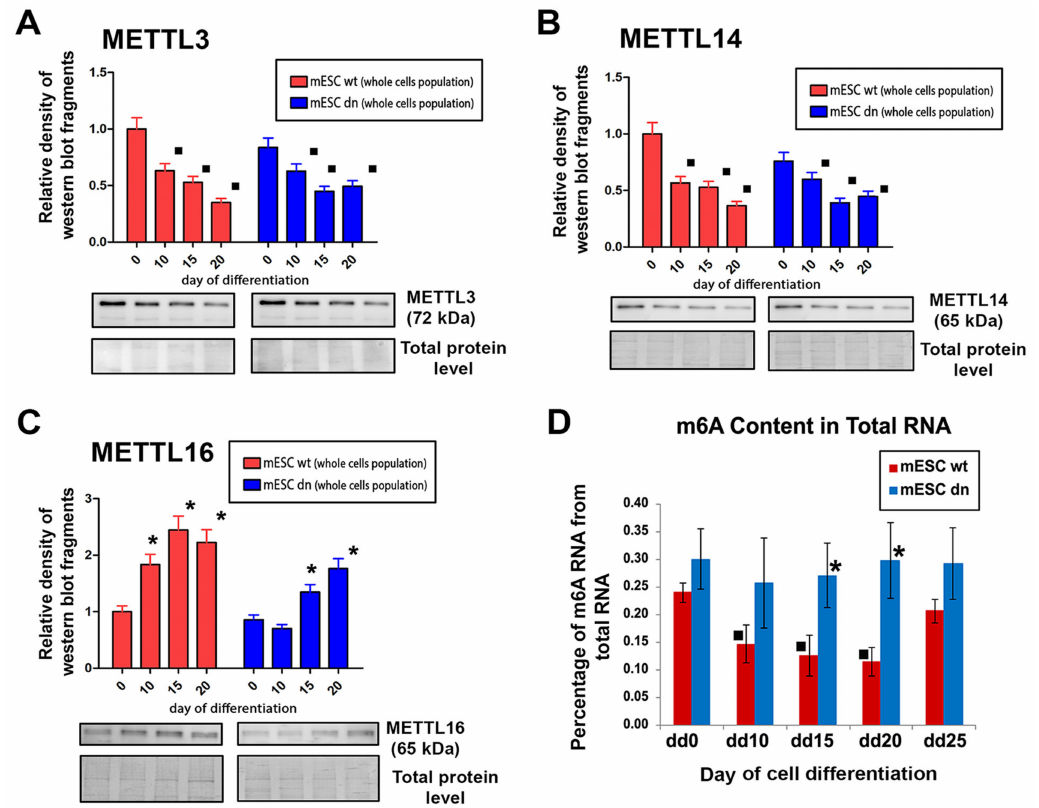
Figure 4. The levels of METTL3 / METTL14, and METTL16 or m6A in RNAs analyzed in HDAC1 wild type (wt) and HDAC1 depleted (dn) mESCs di ff erentiated into multicellular cell populations, including cardiomyocytes. Data from Western blots are shown in the following panels ( A ) METTL3, ( B ) METTL14, and ( C ) METTL16 in HDAC1 wt mESCs and HDAC1 dn mESCs. Squares ( (cid:4) ) show statistically significant di ff erences at p ≤ 0.05 (a decrease in protein levels during di ff erentiation). Data are significantly di ff erent from control values at dd0. Asterisks (*) show statistically significant di ff erences (an increase) in protein levels. ( D ) Methylation of N 6 -adenosine in RNAs was analyzed by the use of colorimetry in non-di ff erentiated and di ff erentiated HDAC1 wt and HDAC1 dn cells at days 0, 10, 15, and 25 of di ff erentiation. This cell population contained cardiomyocytes. The nonparametric Mann–Whitney U test was used for statistical analysis ( α = 0.05). For all analyses, we used results from 3 biological replicates, each consisting of 3 technical replicates (panels ( A – C )). Results in panel ( D ) originate from data of two biological replicates, each consisting of 3 technical